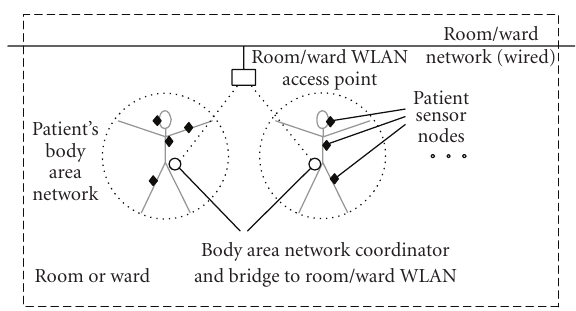
Figure 1: Networking structure of the ward room with BANs, bridges, and ward